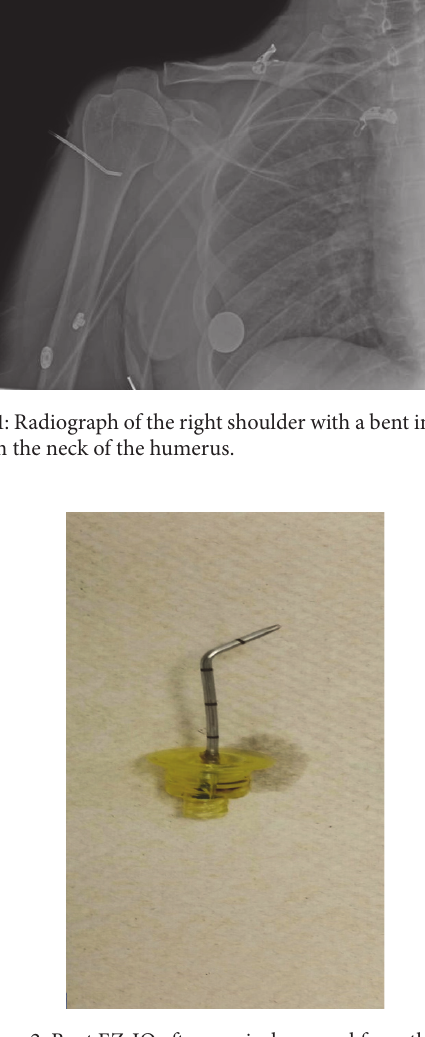
Figure 2: Bent EZ-IO after surgical removal from the